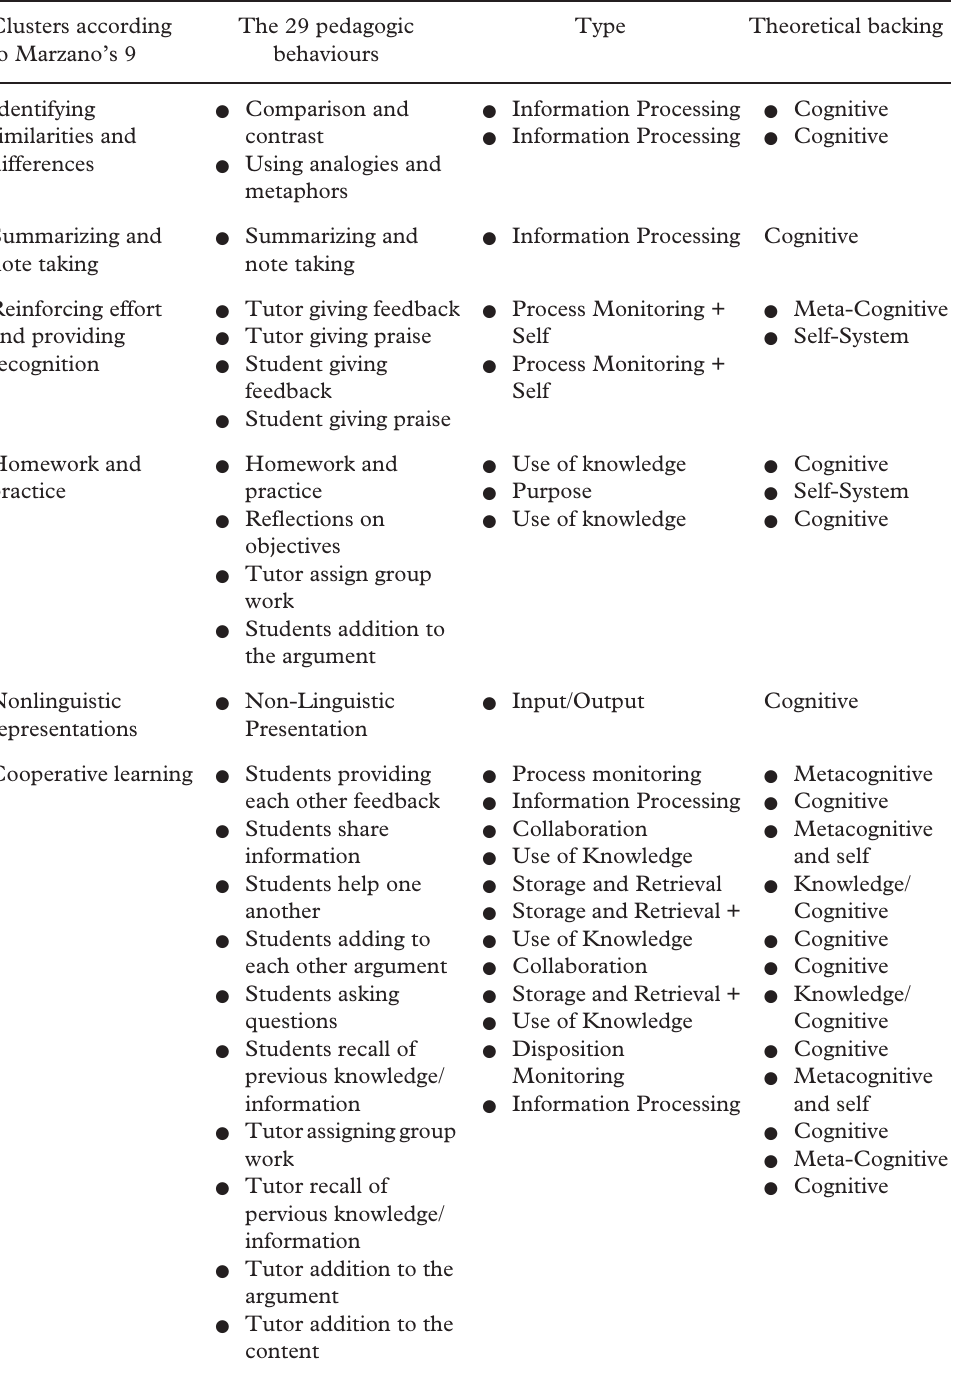
Table 1. Clusters, pedagogies and theoretical